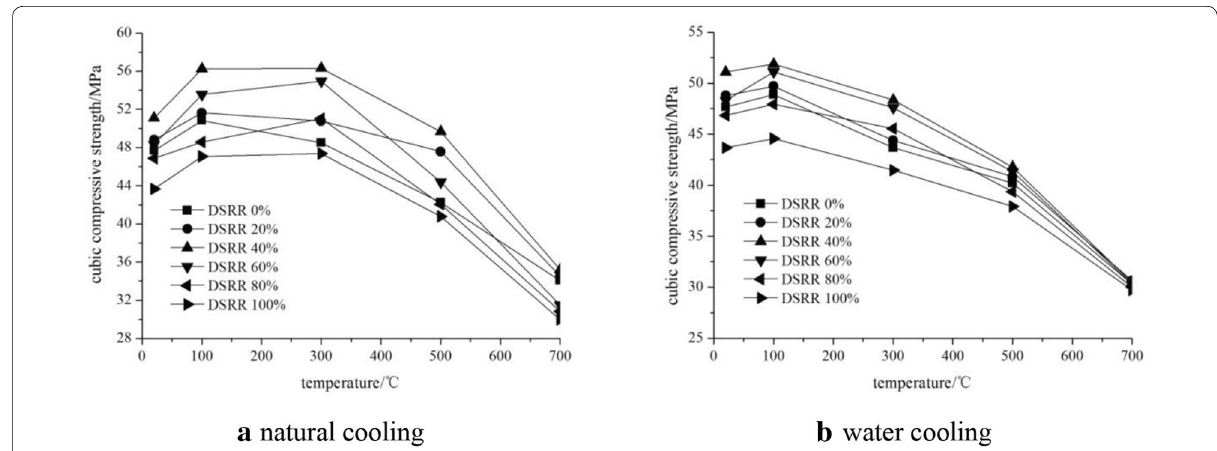
Fig. 4 Relation between the cubic compressive strength of concrete produced with desert sand and temperature.